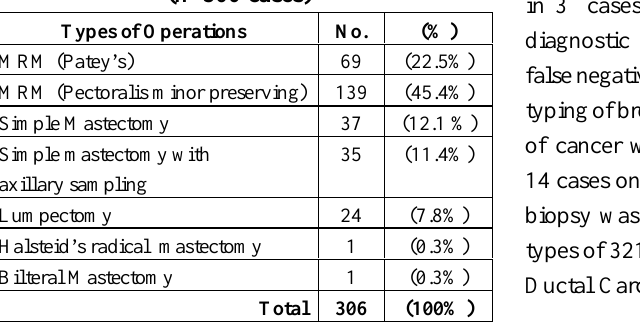
Table V. Types of operation performed (n=306 cases)